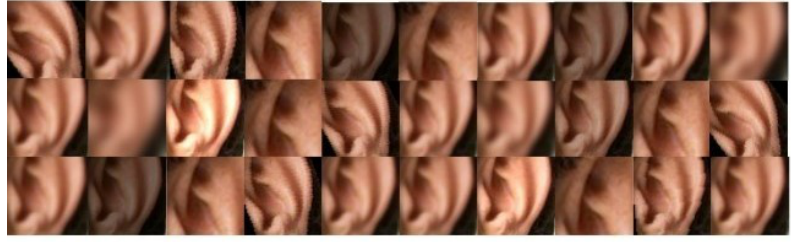
Figure 4. Augmentation